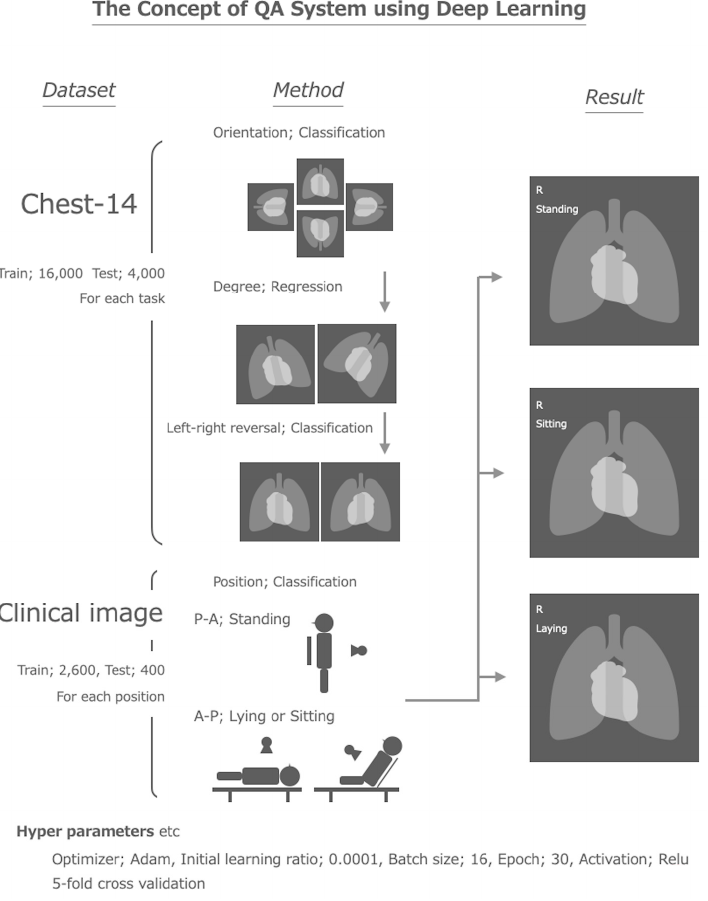
Figure 1. Concept of the QA system. Table 1. Summary of datasets for each training and the overall